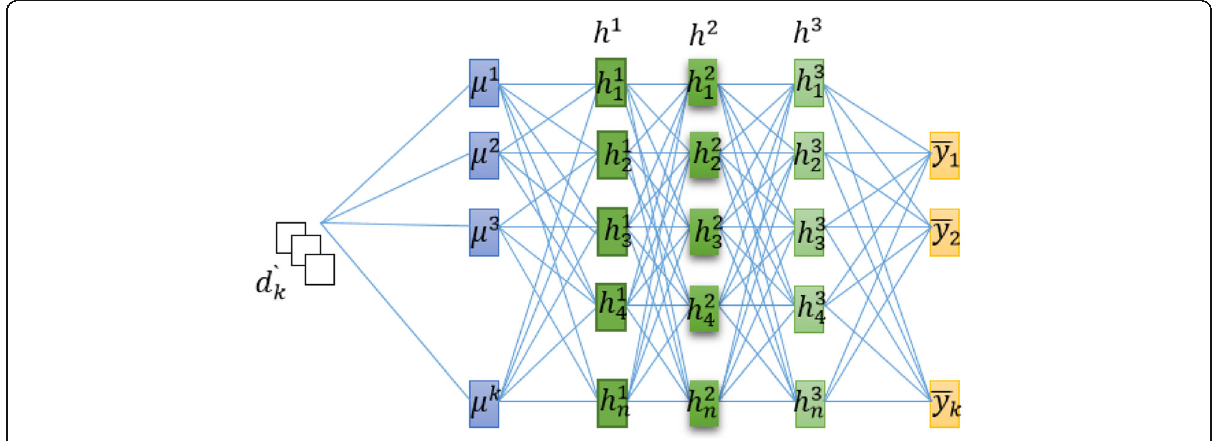
Fig. 2 The Deep Feed Forward Neural Network of the